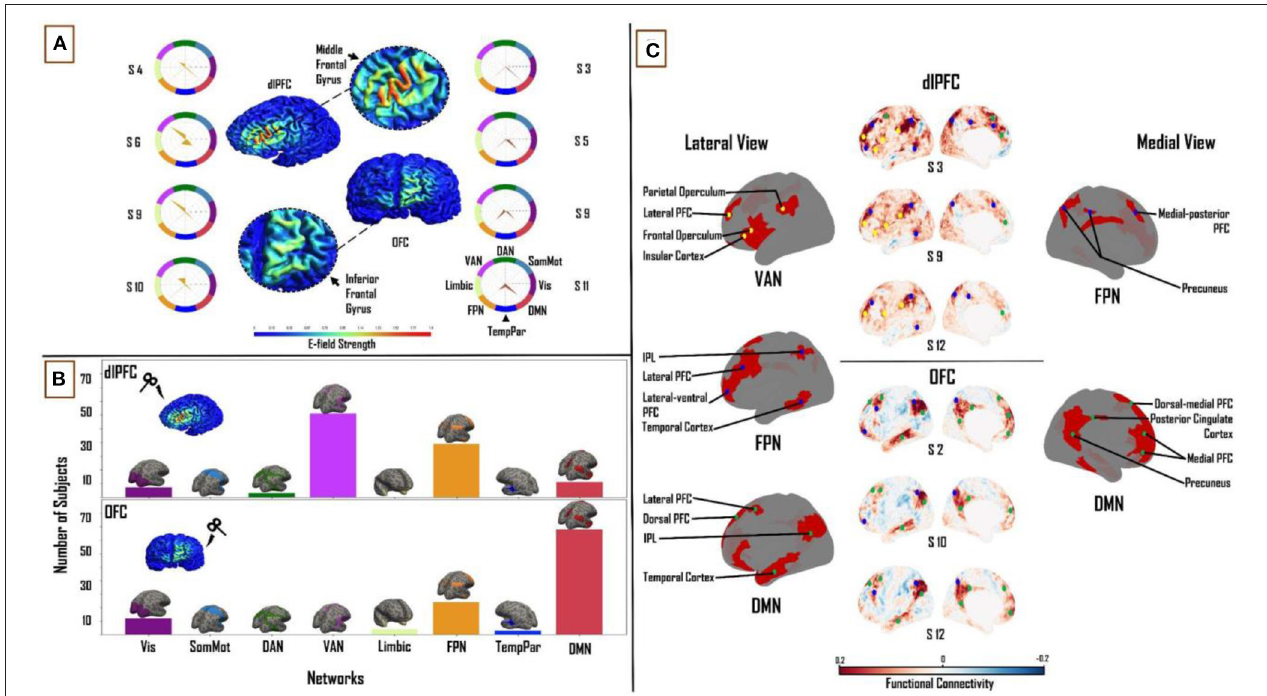
FIGURE 3 | Influence of individual subject FC on TMS target connectivity. (A) Constant (Ernie-based) dlPFC and OFC E-fields, from F3 and Fp1 TMS targets, are 31 mm 2 and 6.3 mm 2 in size, respectively. Spider plots on either side show functional network connectivity (expressed as a percentage of E-field vertices), based on subject-specific FC matrices. E-field strength unit = V/m. (B) Similar to Figure 2 , summary statistics of network engagement over all 121 subjects shows that the VAN, FPN, and DMN were the main networks engaged from the dlPFC [top]; while the FPN and DMN were the main networks engaged from the OFC [bottom] – Refer to Supplementary Figure 4 for a more detailed view of this panel. (C) Top: Lateral and medial view of dlPFC FC maps in subjects 3, 9, and 12, highlighting the key regions that are functionally connected across the VAN, FPN, and DMN. These regions lie mainly in frontal, parietal, and temporal cortices. Bottom: lateral and medial views of OFC FC maps in subjects 2, 10, and 12, highlighting key regions that are functionally connected across the FPN and DMN. These regions lie mainly in medial-frontal, cingulate, and posterior parietal cortices (bottom). VAN, ventral attention network; FPN, frontoparietal network; DMN, default-mode